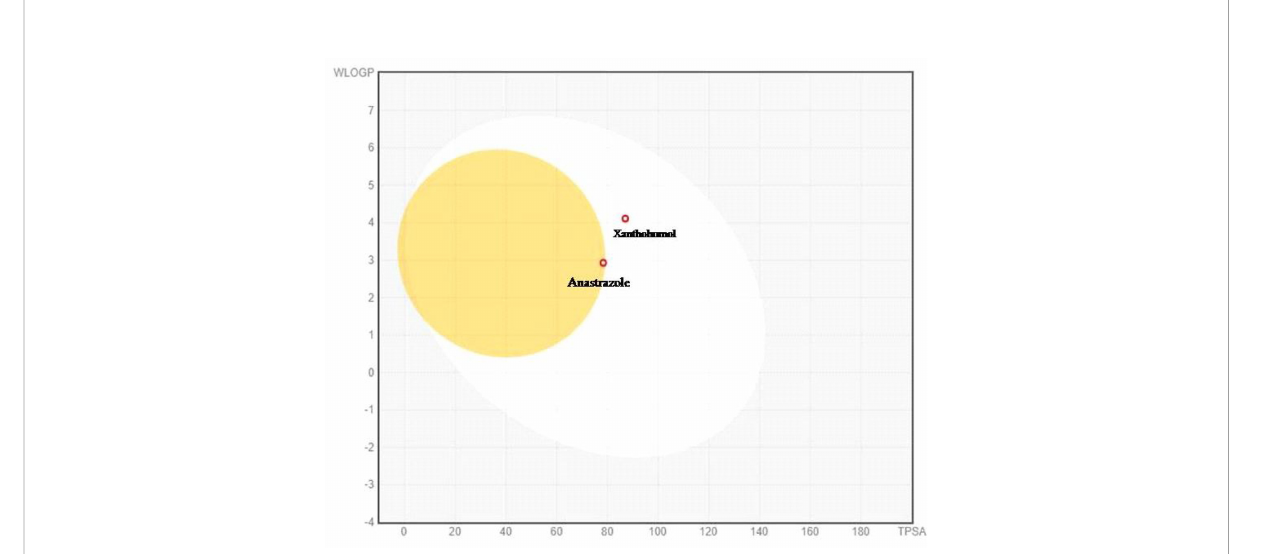
FIGURE 5 Boiled- egg plot between lipophilicity (WLOGP) and polarity (TPSA) showing anastrozole is able to permeate blood – brain barrier (BBB) and xanthohumol showing passive absorption by gastrointestinal tract. Molecules with red dots are anticipated to be unaffected by P-glycoprotein- mediated central nervous system (CNS)